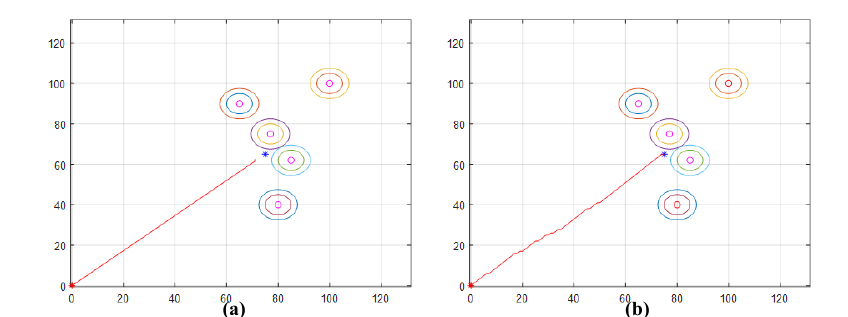
Fig. 10. Traditional artificial potential field algorithm and modified algorithm in scenario